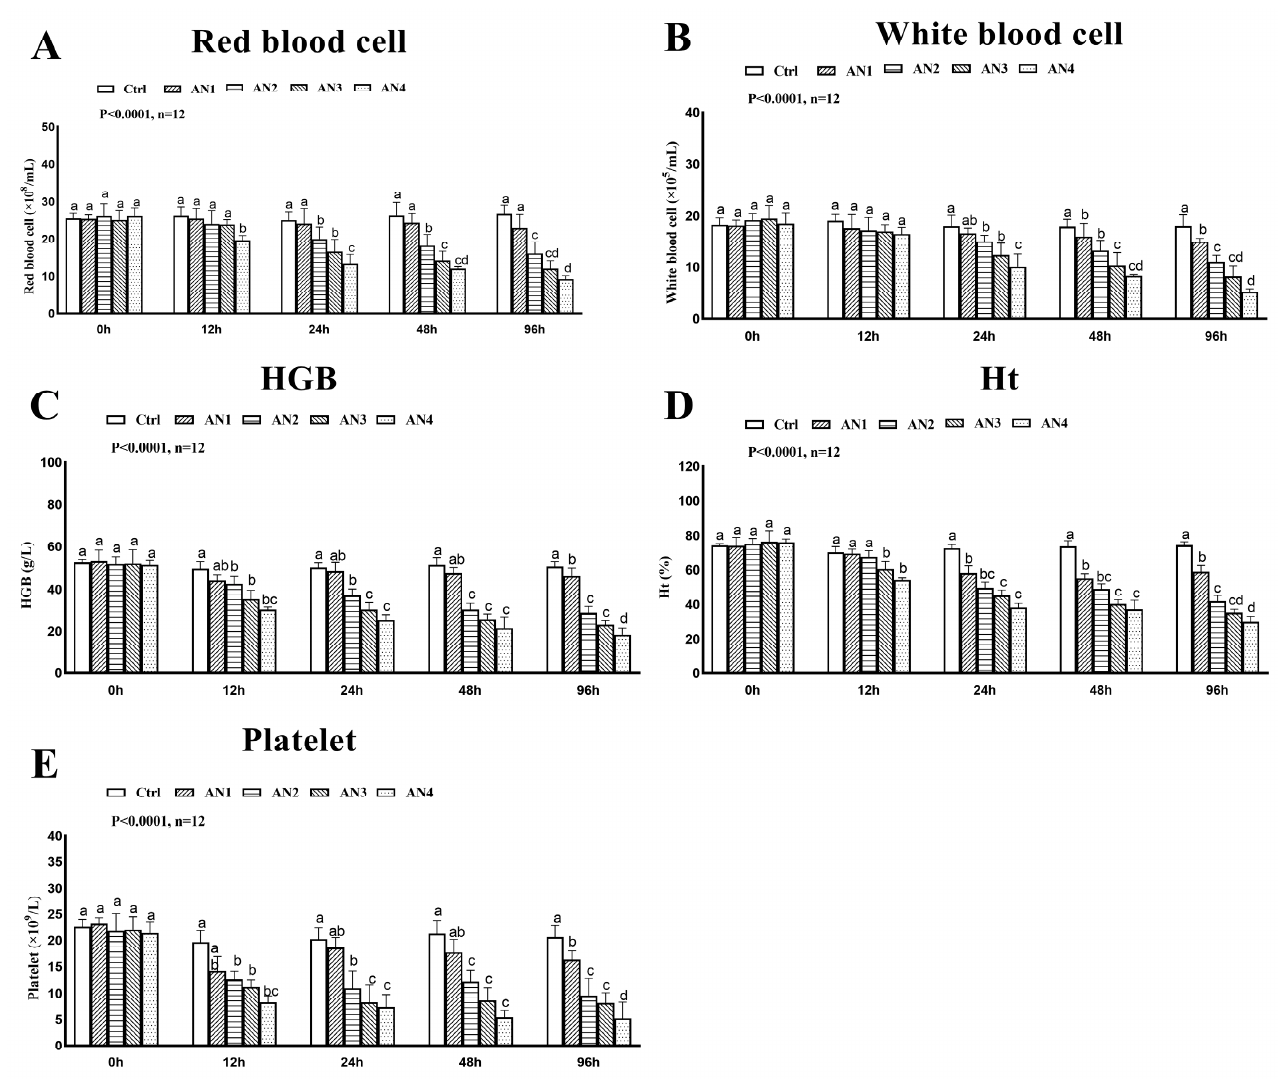
Figure 1. Changes of hematological parameters of bighead carp exposed to ammonia. ( A ) Red blood cell (RBC), ( B ) white blood cell (WBC), ( C ) hemoglobin (HGB), ( D ) hematocrit (Ht), ( E ) platelet (PLT). Note: Values are expressed as mean ± standard error (SE) from triplicate groups. Bars with different letters (a, b, c, d) differ significantly from those of other groups ( p < 0.05).